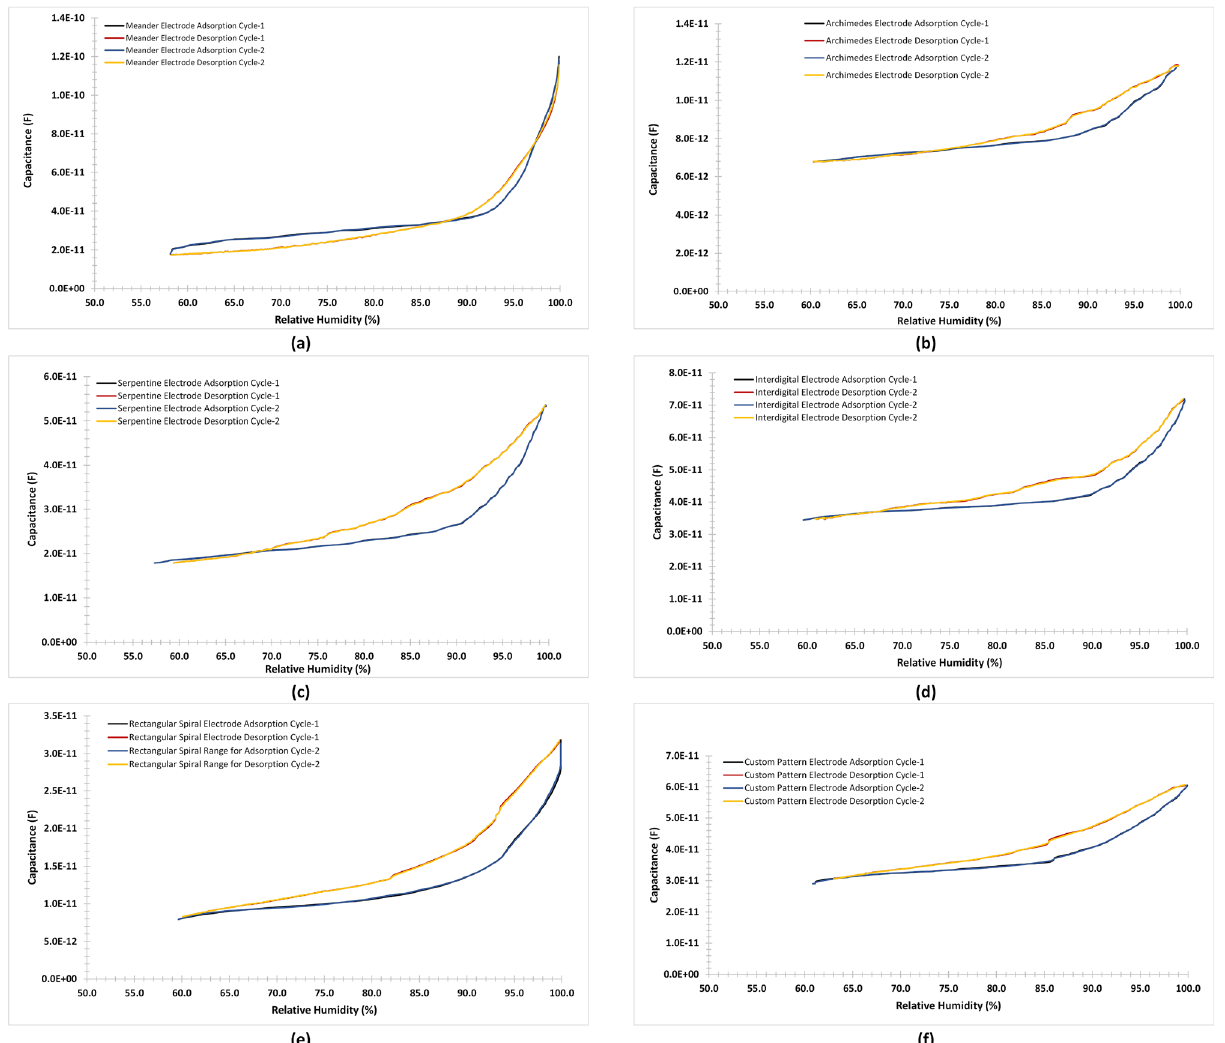
Figure 8. Adsorption and desorption cycle of patterned sensors for ( a ) Meander, ( b ) Archimedes spiral, ( c ) Serpentine, ( d ) Interdigital, ( e ) Rectangular spiral, and ( f ) Custom